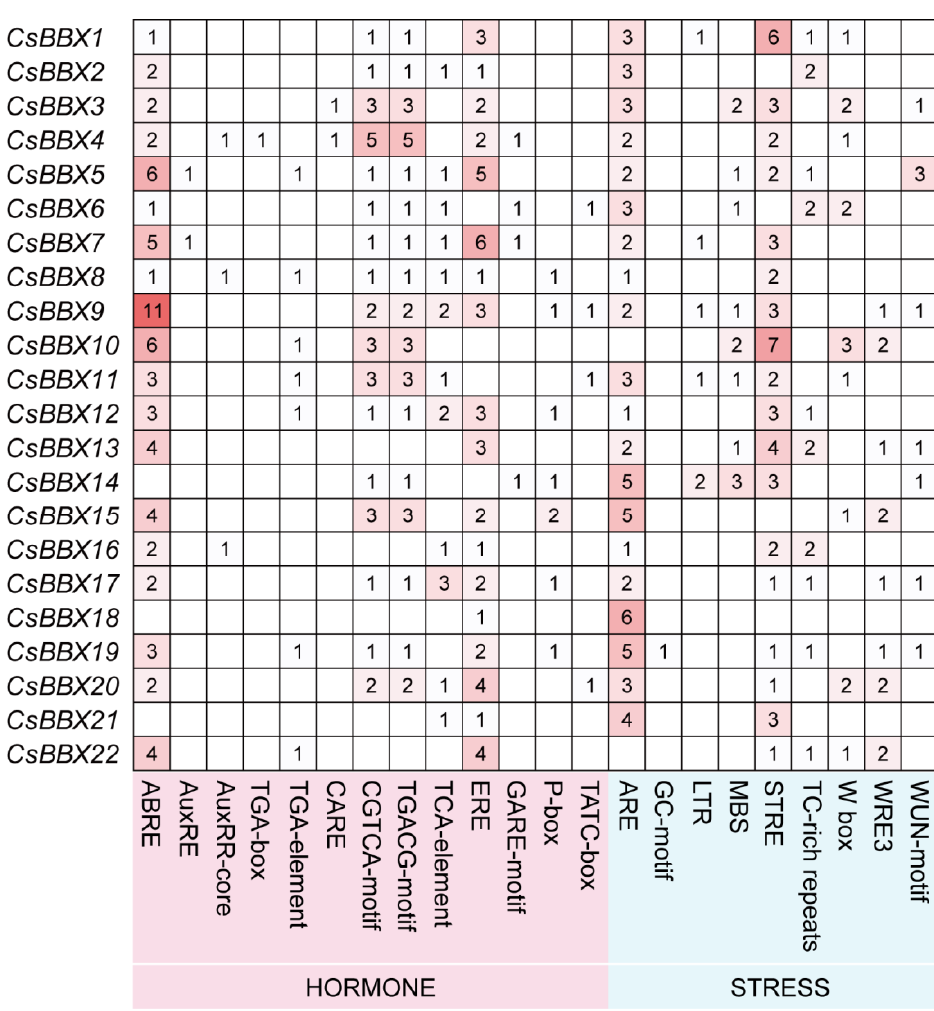
Figure 4. Types and numbers of hormone- and stress-related cis -elements in CsBBX promoter re-